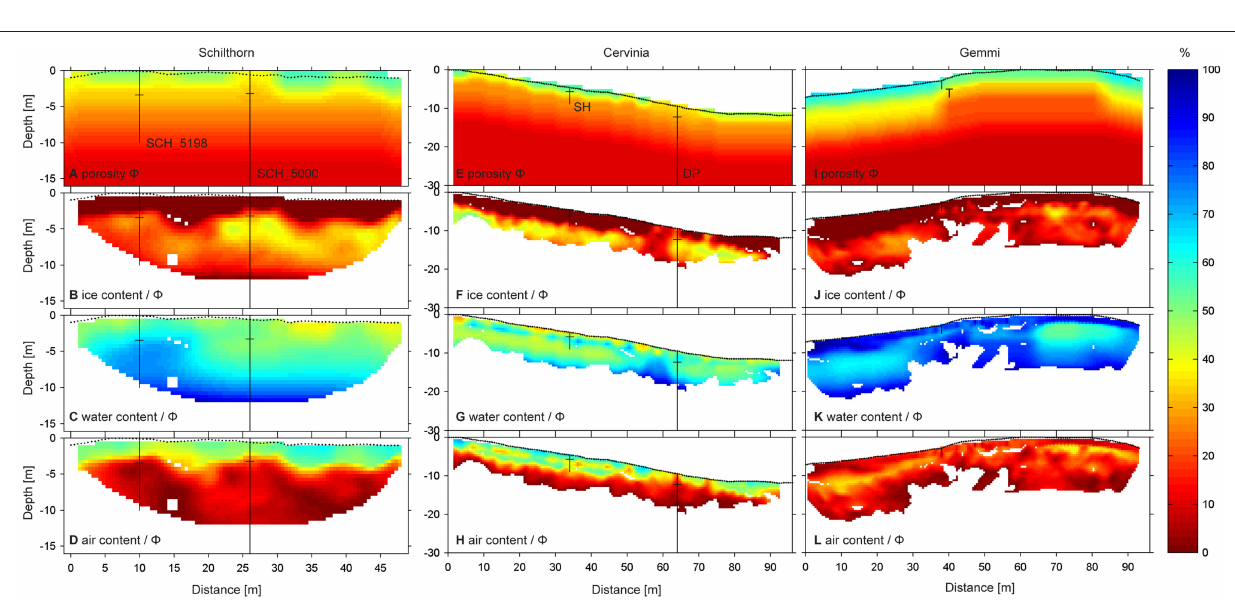
FIGURE 7 | 4PM modeled relative ice- (B,F,J), water- (C,G,K), and air- (D,H,L) contents at Schilthorn, Cervinia, and Gemmi using best guess porosity models (A,E,I). The borehole locations and temperature profiles are marked by vertical black lines and the measured ALT at the boreholes by horizontal